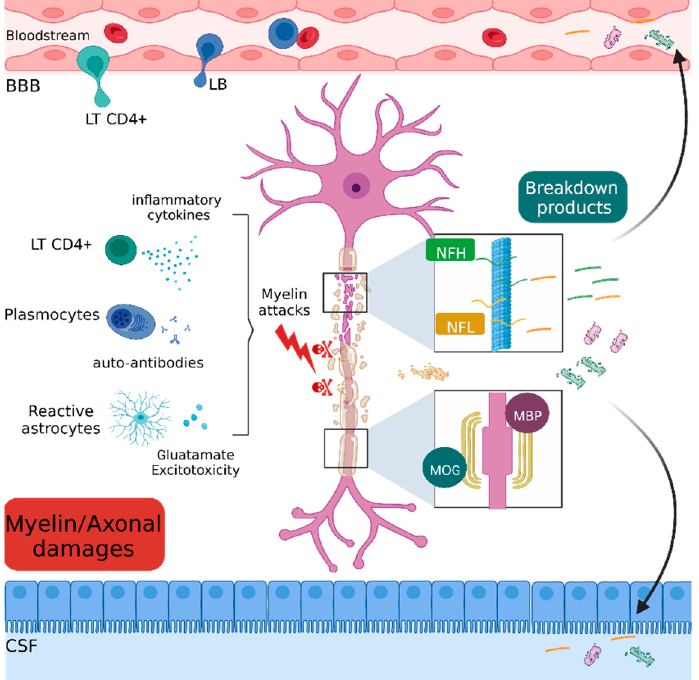
Figure 4. Schematic representation of myelin and axonal damages. BBB: Blood brain barrier, LT CD4 + : CD4 T lymphocyte, LB: lymphocyte B, MBP: myelin binding protein, MOG: myelin and oligodendrocyte glycoprotein, NFH: neurofilament heavy chain, NFL: neurofilament light chain.